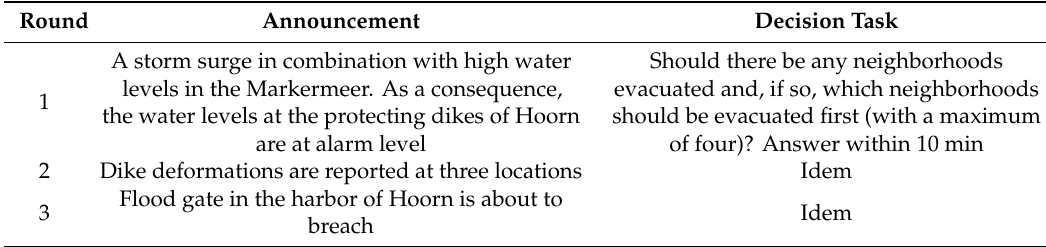
Table 2. Disaster